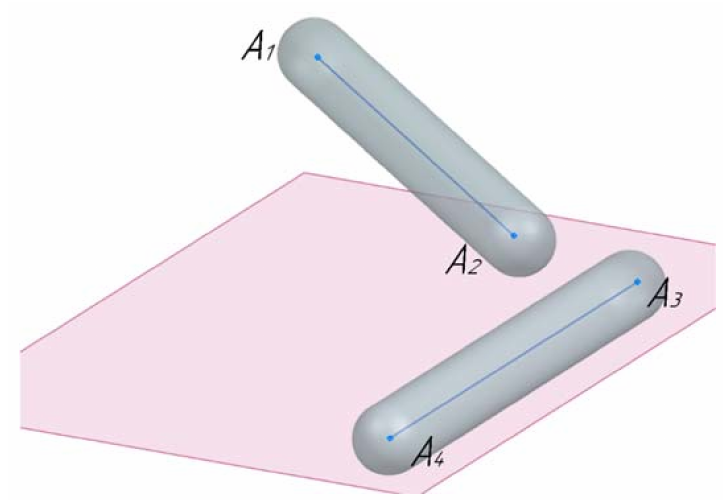
Figure 3. Representation of the links of the